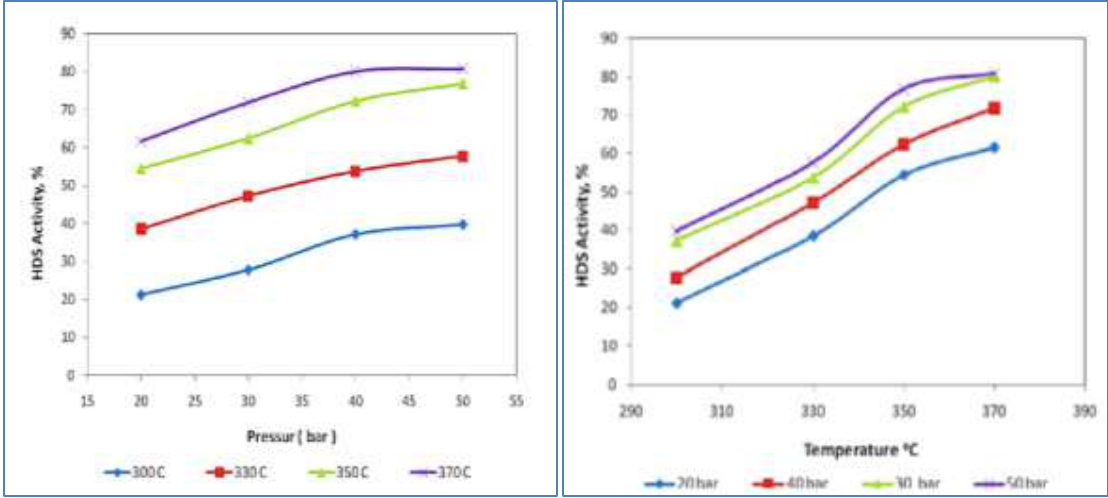
Figure 3: The effect of pressure and temp. On the removal efficiency of sulfur compounds by HDS desulfurization